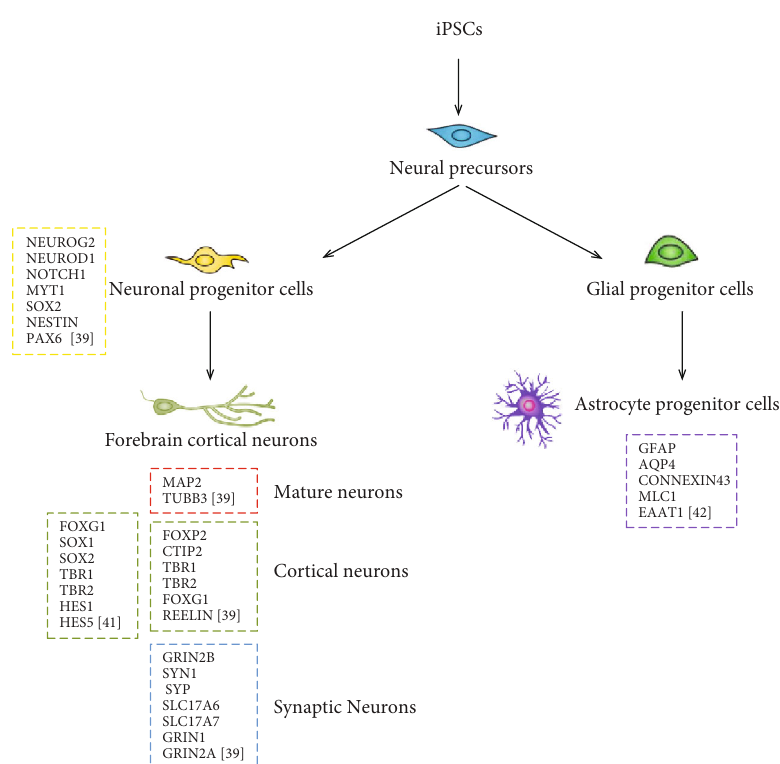
Figure 1: Molecular barcoding gene signatures in human PSC neural di ff erentiation. Schematic representation of the major lineages generated from human PSCs upon neural di ff erentiation. Gene expression signatures identi fi ed by digital color-coded barcoding are indicated. References are